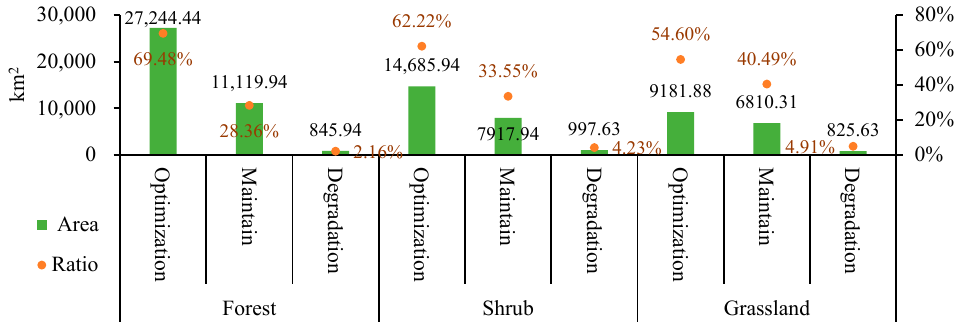
Figure 9. Statistics of changes in the quality of natural ecosystem assets in the Beijing–Tianjin–Hebei urban agglomeration from 2000 to 2015.